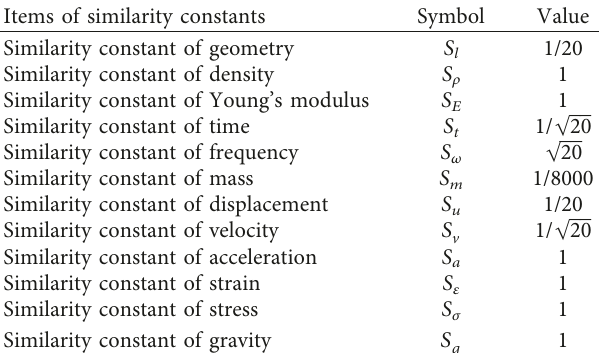
Figure 1: Structural model of the quayside container crane. Table 1: Similarity constants of the